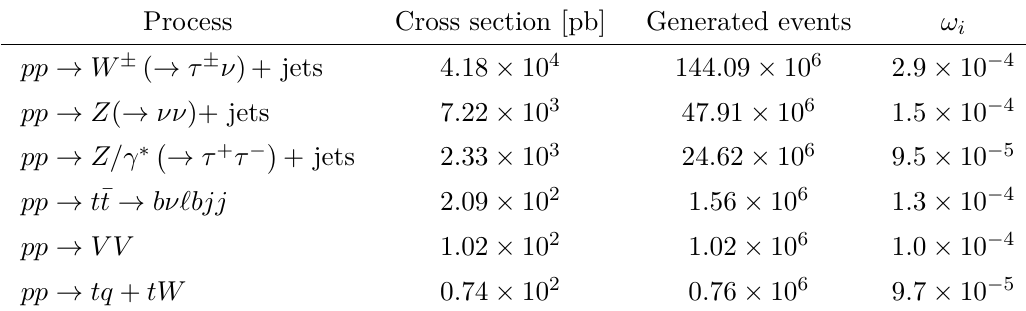
Table 8 . Cross sections, number of generated events and event weights for the different background processes leading to a cτ plus MET signature. Single top quark production ( tq + tW ) includes decays into a single-lepton final